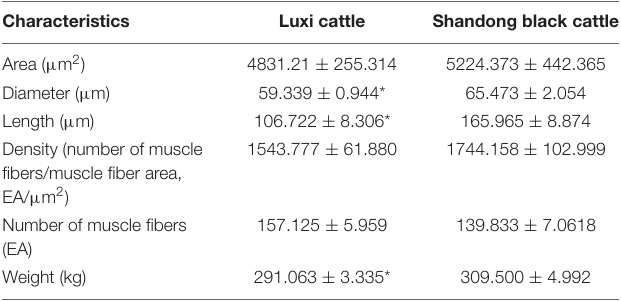
number of nucleus in each muscle fiber was also greater. The boundary between the muscle fibers of Shandong black cattle was clearer and rounder than that of Luxi cattle. IPP software analysis fiber diameter, length and weight ( P < 0.05) but no significant